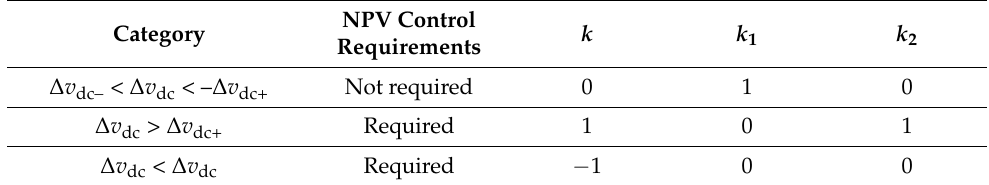
Table 2. Judgment rule of NPV control requirements.